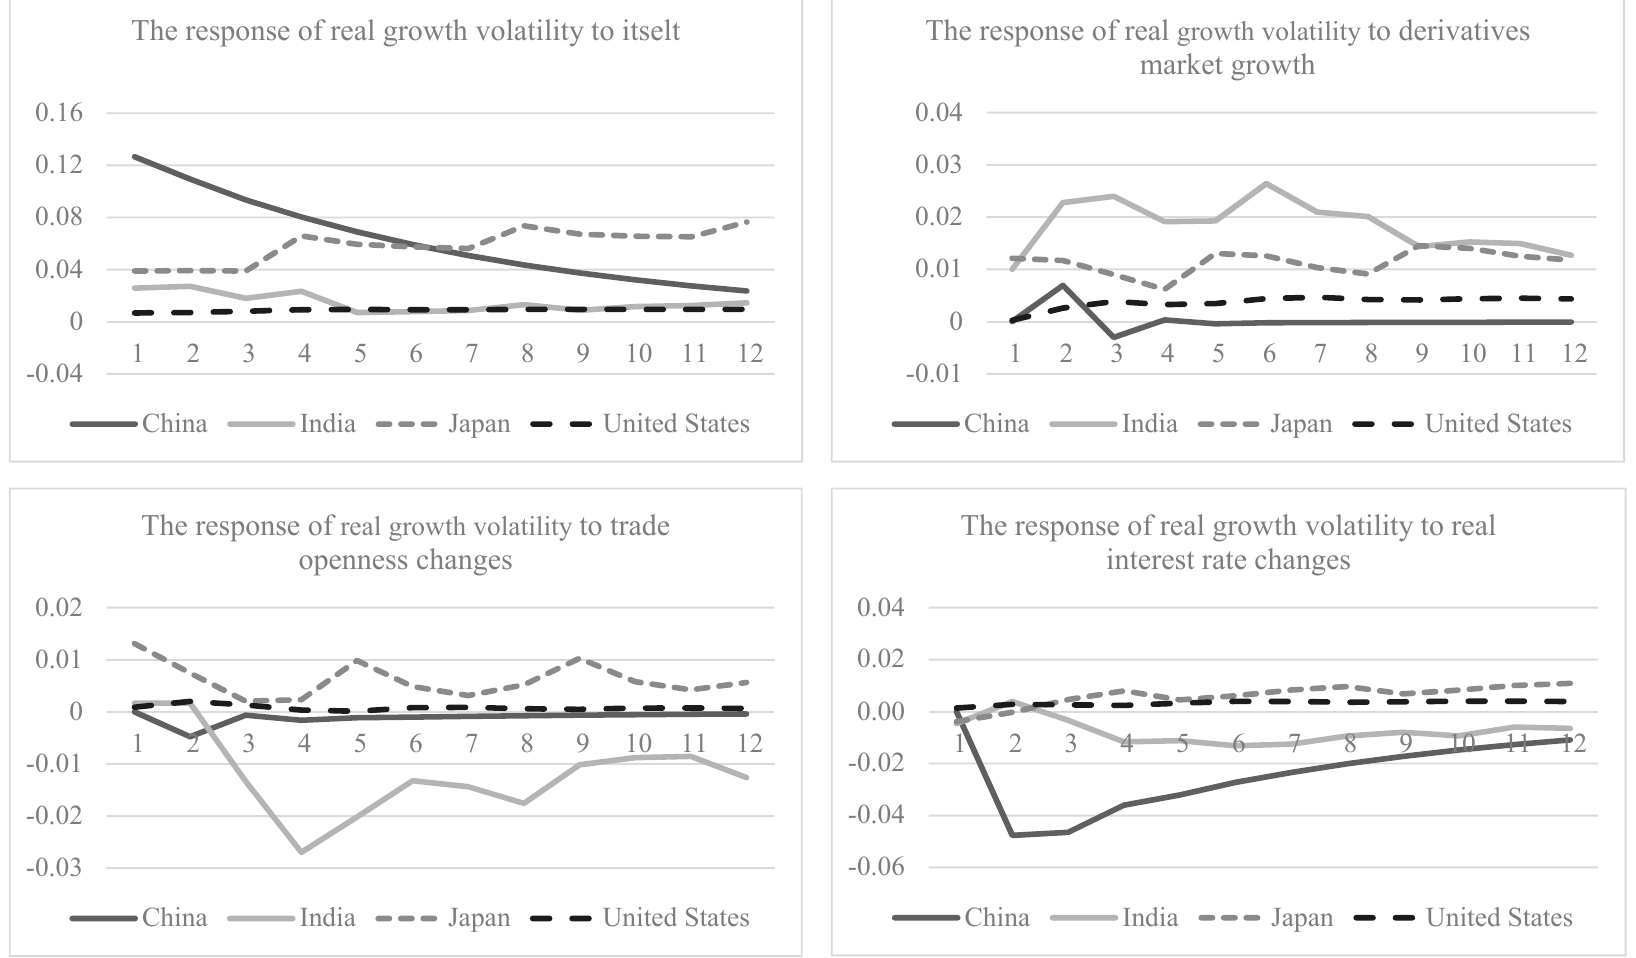
Figure 3. Cumulative orthogonalized impulse response function (the model include the volatility of GDP growth).